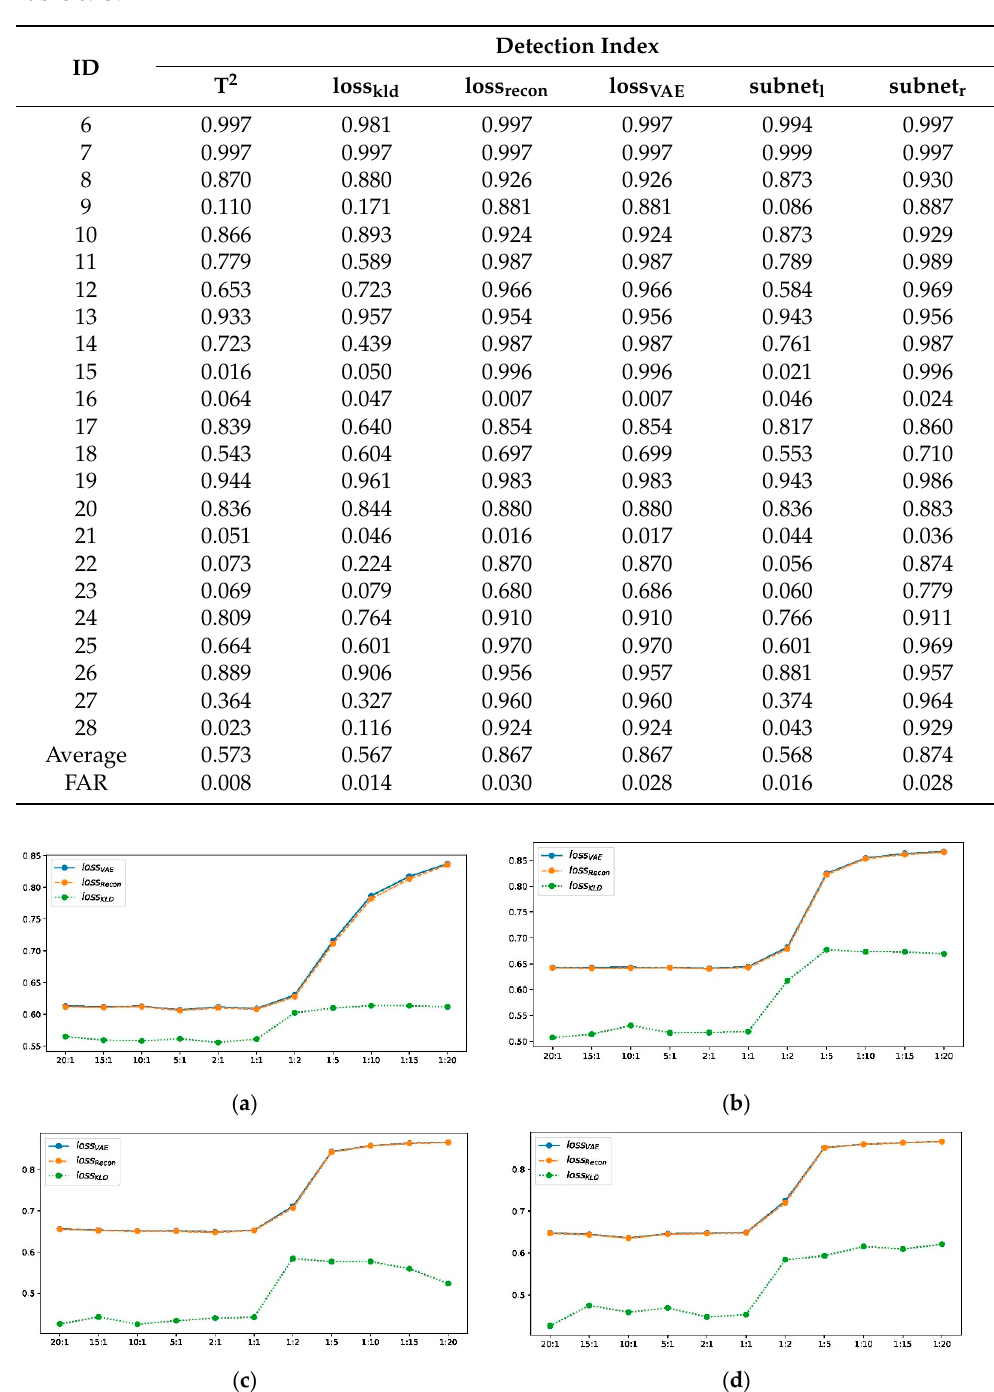
Figure 4. Detection accuracy with different VAE loss weight